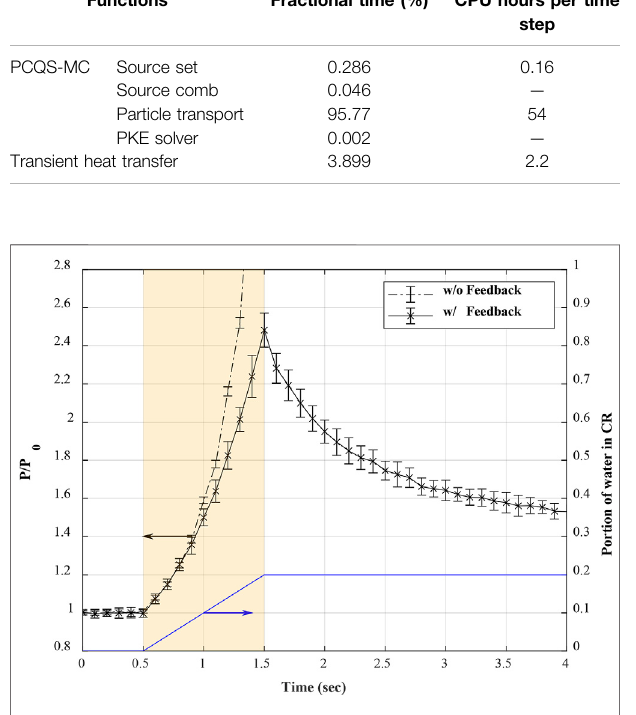
FIGURE 5 | Time-dependent reactor power without feedback (dashed line) and with feedback (solid line) under a given portion of water mixed with control rods (blue